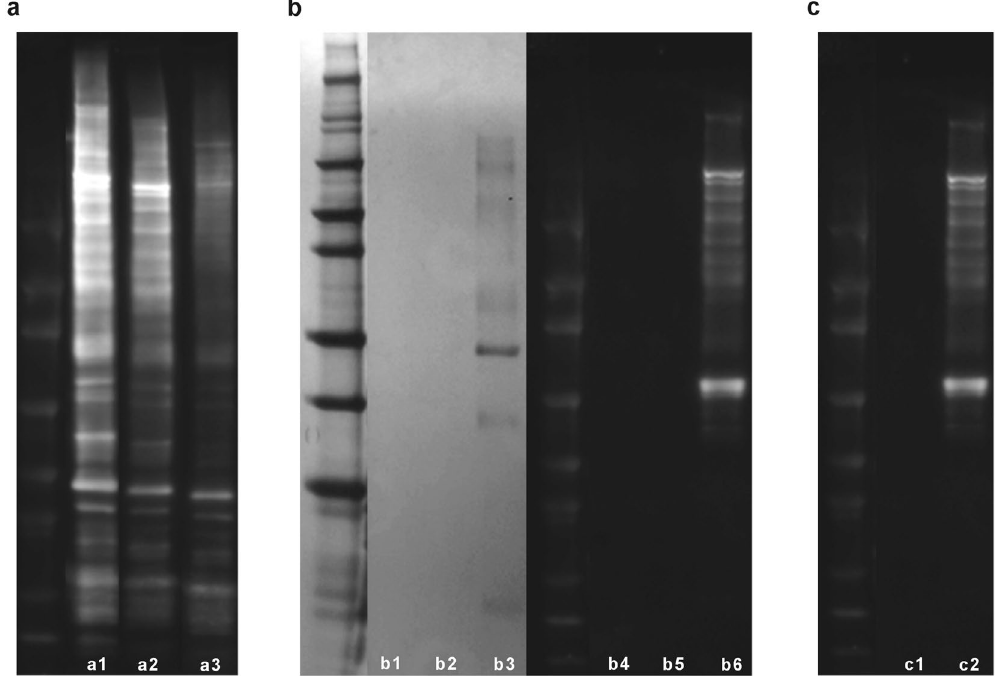
Figure 3. Western blot and silver stain of protein eluates. Western blot of total native protein extract (a1), protein extract run-through from D0 column (a2), and protein extract run-through from D84 column (a3). Both D0 and D84 columns demonstrate decreased antigenic protein content in column run-through, with greater removal of antigenic bands in D84 column. Silver stain for SDS-page gel of D84 pH 5, 4, and 2.9 eluates ((b1,b2 and b3) respectively) and corresponding D84 Western blot from pH 5, 4, and 2.9 eluates ((b4,b5 and b6) respectively), confirming that minimal non-specific binding is present and that all specifically bound proteins (pH 2.9 eluates) are antigenic. Comparison of D0 and D84 eluates at pH 2.9, demonstrating that more antigens are specifically captured from D84 columns (c2) than from D0 columns (c1). ( n = 4 per extraction method and timepoint). Western blot and silver stained gel were cropped for easier visualization, uncropped images are available in the supplemental